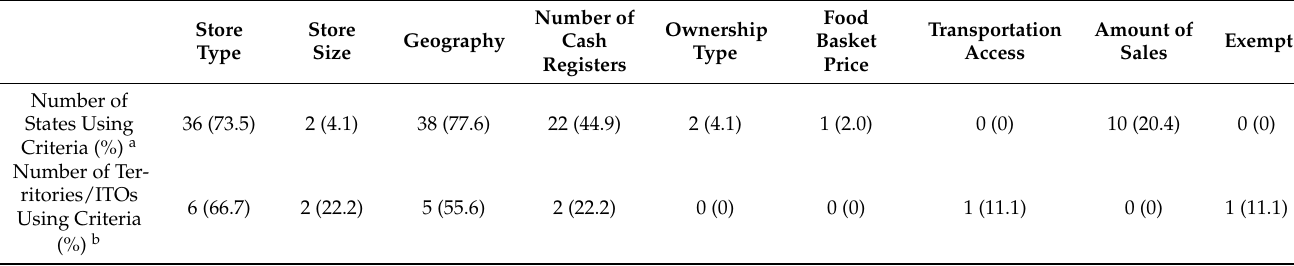
Table 4. Vendor Peer Group System Criteria for Administrative Agency-Authorized WIC Retailers, 2018–2020.